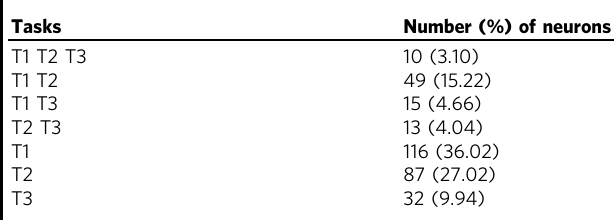
Table 2 Total number of boundary neurons per